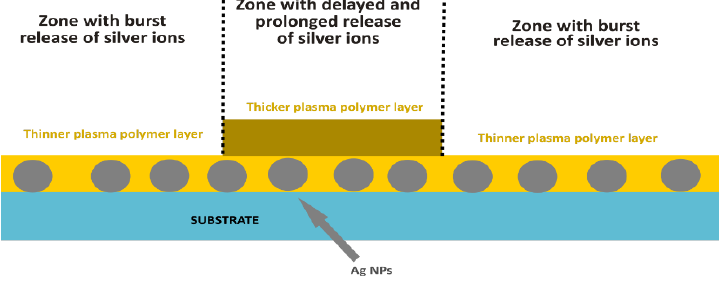
Figure 7. Scheme of Ag/plasma polymer coating with non-monotonous kinetics of release of silver ions.